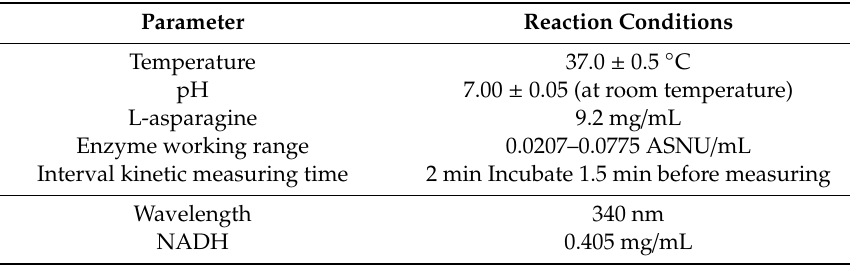
Table 1. Parameters for enzyme reactions